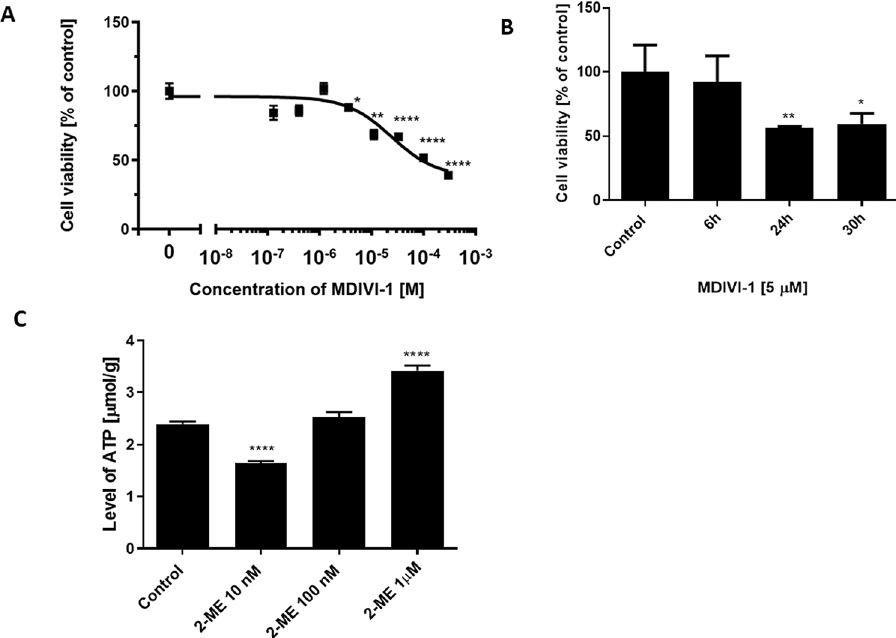
Figure 4. MDIVI-1 exerts cytotoxic effect in OS 143B cells. 2-ME regulates the ATP intracellular level in OS 143B cells. ( A ) MDIVI –1 significantly decreases OS 143B cell viability in a dose-dependent manner at concentrations higher than 10 –6 . OS 143B cells were treated with serial dilutions of MDIVI-1 within concentrations range of 300–0.1 µM for 24 h. The cell viability was determined by MTT assay. ( B ) Incubation of OS 143B cells with 5 µM MDIVI-1 1 for 6 h does not affect cell viability. ( C ) Changes in cellular level of ATP after 8 h-treatment of OS 143B cells with 10 nM, 100 nM, and 1 µM 2-ME. Values are the mean ± SD of three independent experiments. * p < 0.01, ** p < 0.001, *** p < 0.0001, **** p < 0.00001 versus control cells.